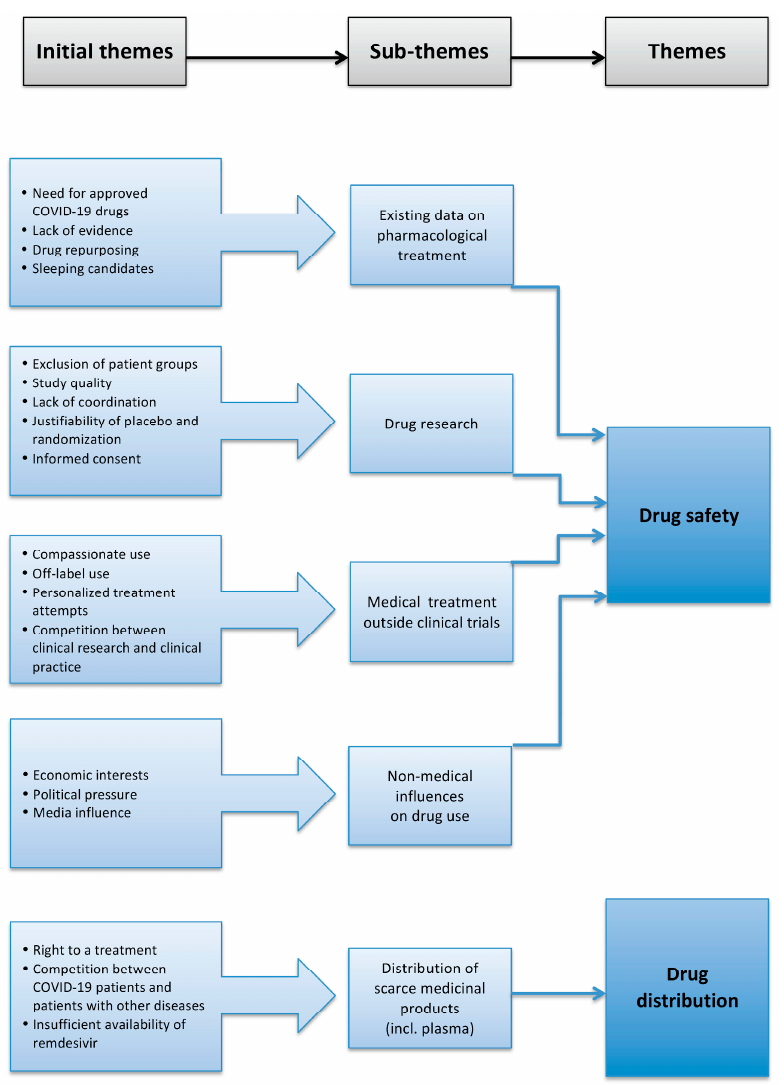
Figure 1. Development of the two main themes “drug safety” and “drug distribution” from five sub-themes formed out of 19 initial themes.